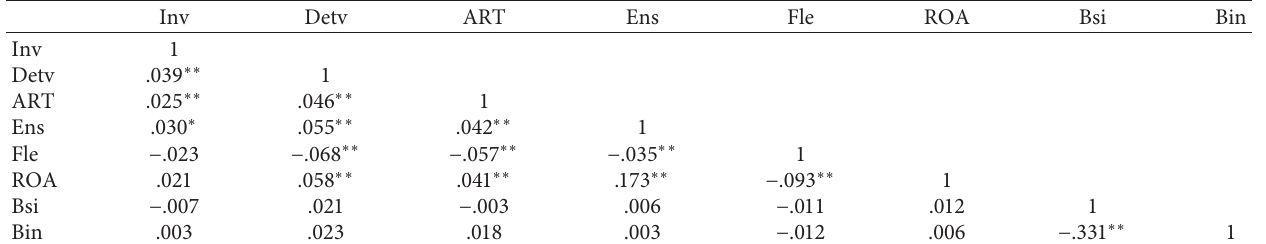
Table 3: Pearson correlation